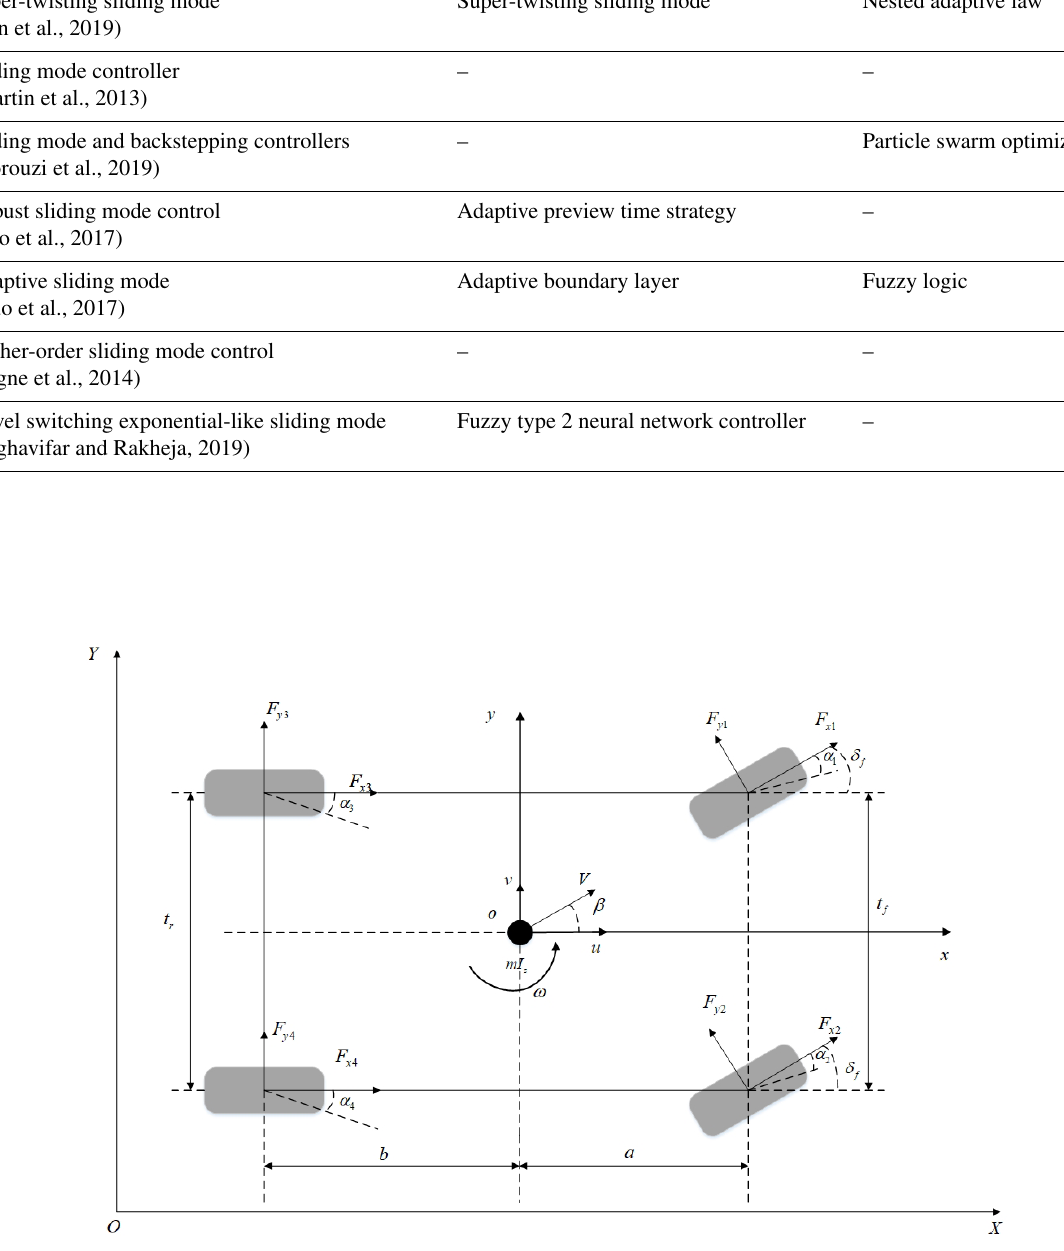
Figure 1. Vehicle model with 3